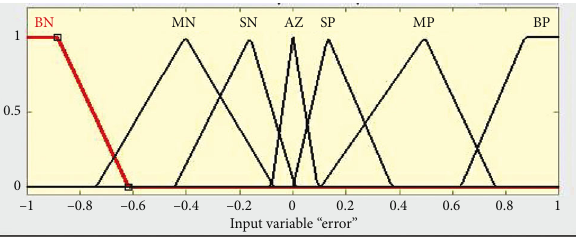
Figure 9: Tuned input membership function for current error.